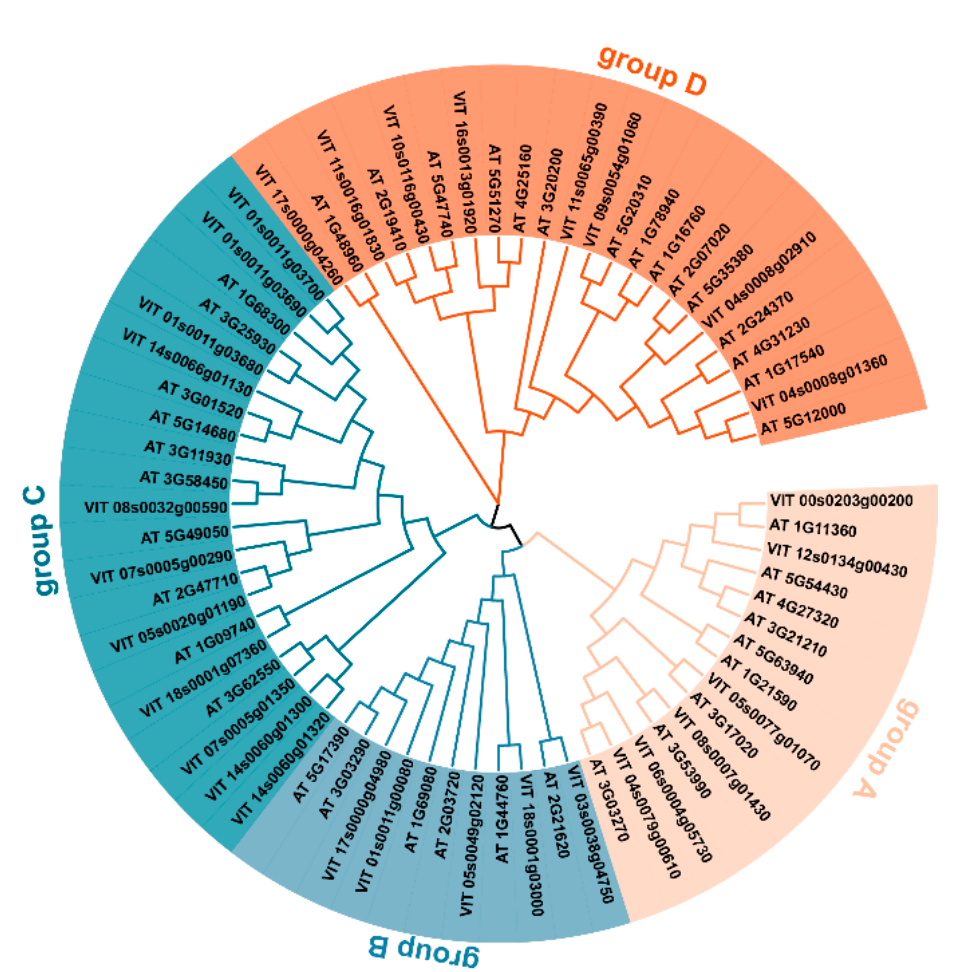
Figure 1. Phylogenetic analysis of VvUSPs and AtUSPs. In order to assess whether the hierarchical clustering observed (Figure 1) reflected differences in USP functionalities, a phylogenetic tree of 30 VvUSPs (Figure 2a) was con- structed and superimposed on conserved motif content (b) and gene structure (c). Ten conserved motifs were found to be present among the 30 VvUSP proteins (Figure S1 and Table S3), but their distribution varied between the different VvUSPs, which con- tained from only one to up to seven conserved motifs (Figure 2b). With the exception of motif 4. However, motifs 1, 7 and 9 were restricted to classes I and III, whereas motifs 2, 3, 5, 6, 8 and 10 were present only in class II. In general, the distribution of conserved motifs can be seen to reflect the hierarchical clustering based on VvUSP primary sequences. The analysis of the gene structure (Figure 2c) shows that 29/30 VvUSPs contained identifiable intron regions. The exception to this was VIT_11s0065g00390, which may be caused by functional differentiation during evolution. In class I, most genes contain two intron regions and three to seven exons. In addition, the number of exons in class II VvUSPs is relatively high compared with the other